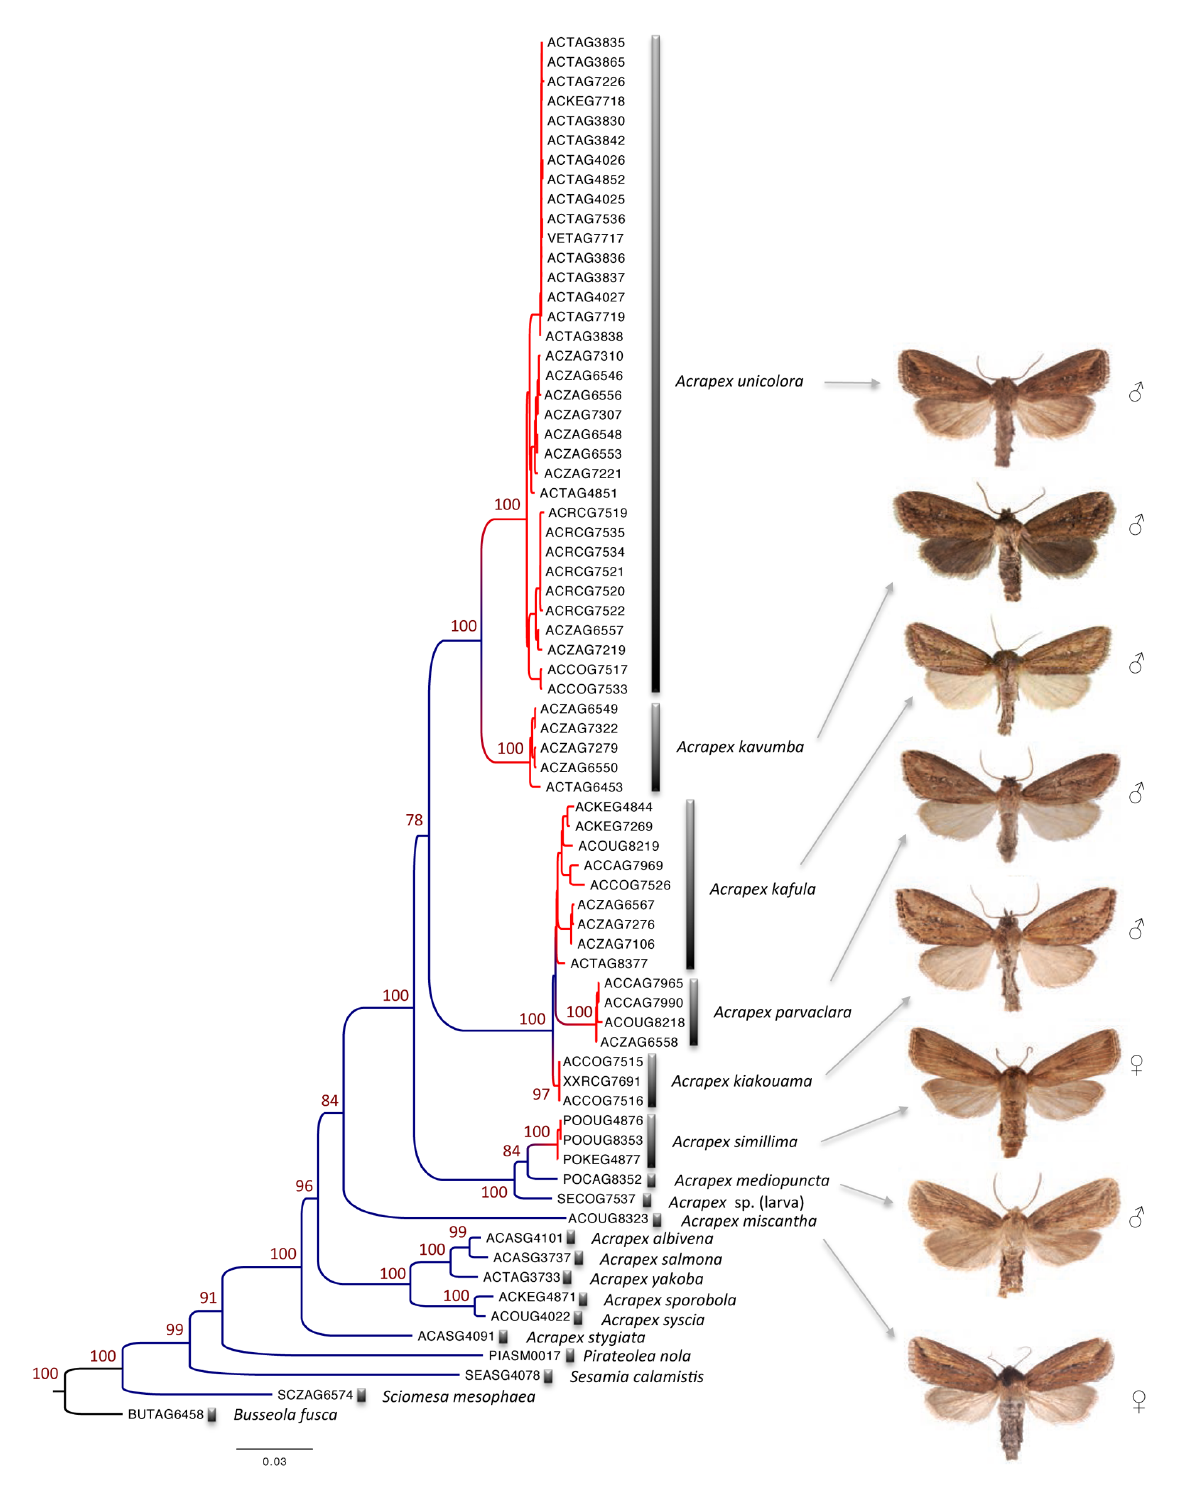
Fig. 10. Maximum likelihood tree resulting from the analysis of the combined dataset carried out with IQ-TREE. Support of major nodes is displayed as BV (only BV > 50% are shown). On the right, corresponding adult habitus (for species belonging to the A. unicolora species group) are also included for illustrative purposes. Results of PTP analyses are figured using coloured branches and vertical side bars. Putative molecular species clusters are indicated using transitions between blue-coloured branches to red-coloured branches (vertical bars are also